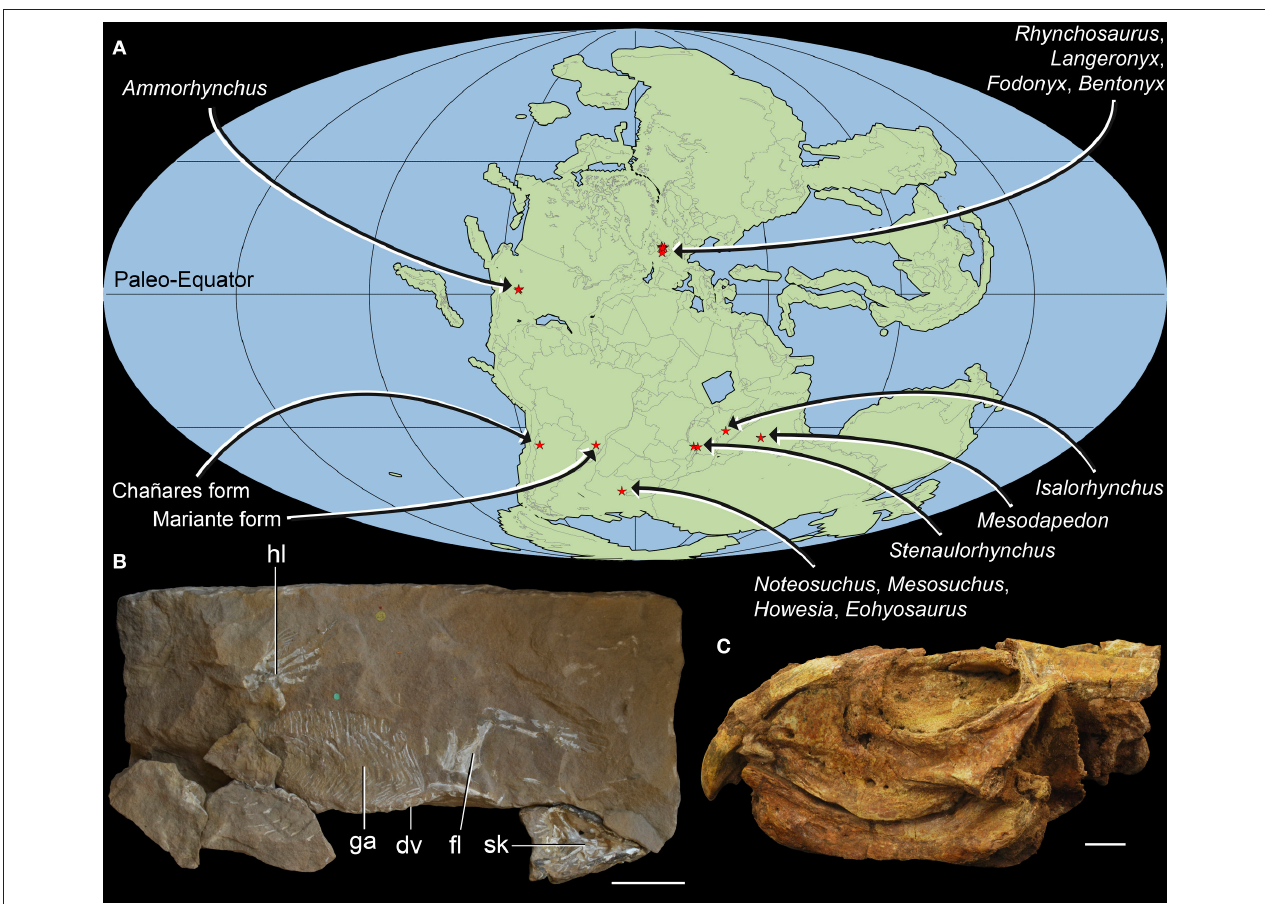
FIGURE 1 | Geographic distribution and overall morphology of Early-Middle Triassic rhynchosaurs. Paleomap showing geographical distribution (A) and early rhynchosaurid morphology exemplified by (B) a partial skeleton of Rhynchosaurus articeps (NHMUK PV R1237, R1238) and (C) the fairly complete skull of Bentonyx sidensis (BRSUG 27200, holotype). Abbreviations: dv, dorsal vertebrae; fl, forelimb; ga, gastralia; hl, hindlimb; sk, skull. Scale bars equal to 5cm in (B) and 1cm in (C) . Map (A) generated using Fossilworks tools created by Alroy (2013) using a map for 240 million years ago created by Scotese (2001) and data from the Paleobiology Database (www.paleobiodb.org).